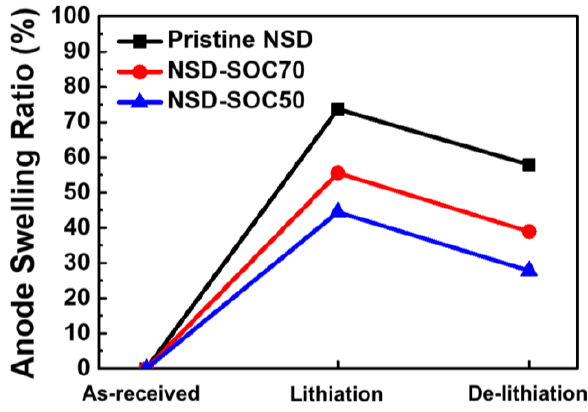
Figure 4. Swelling behavior of NSD electrodes.